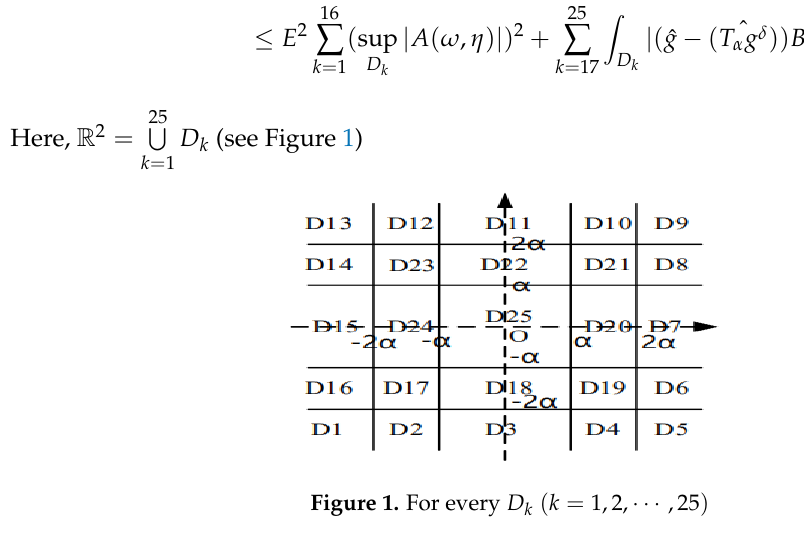
Figure 1. For every D k ( k = 1,2, · · · ,25